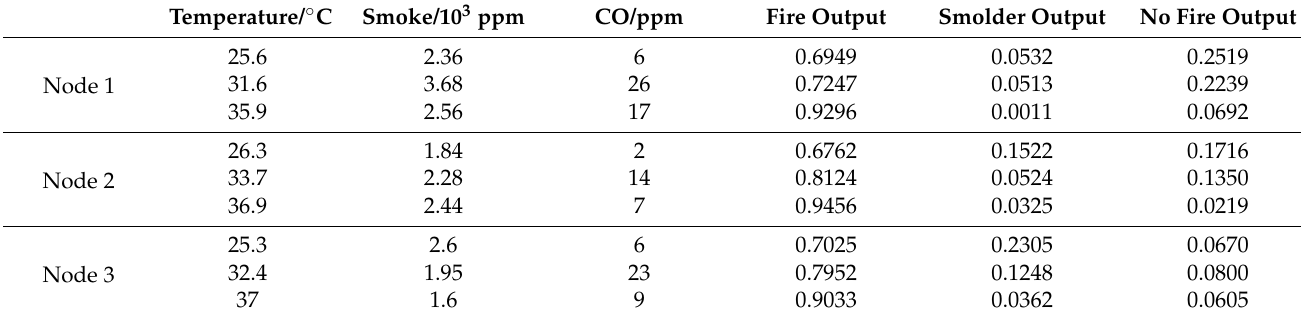
Table 9. The GA-BP algorithm fusion results.